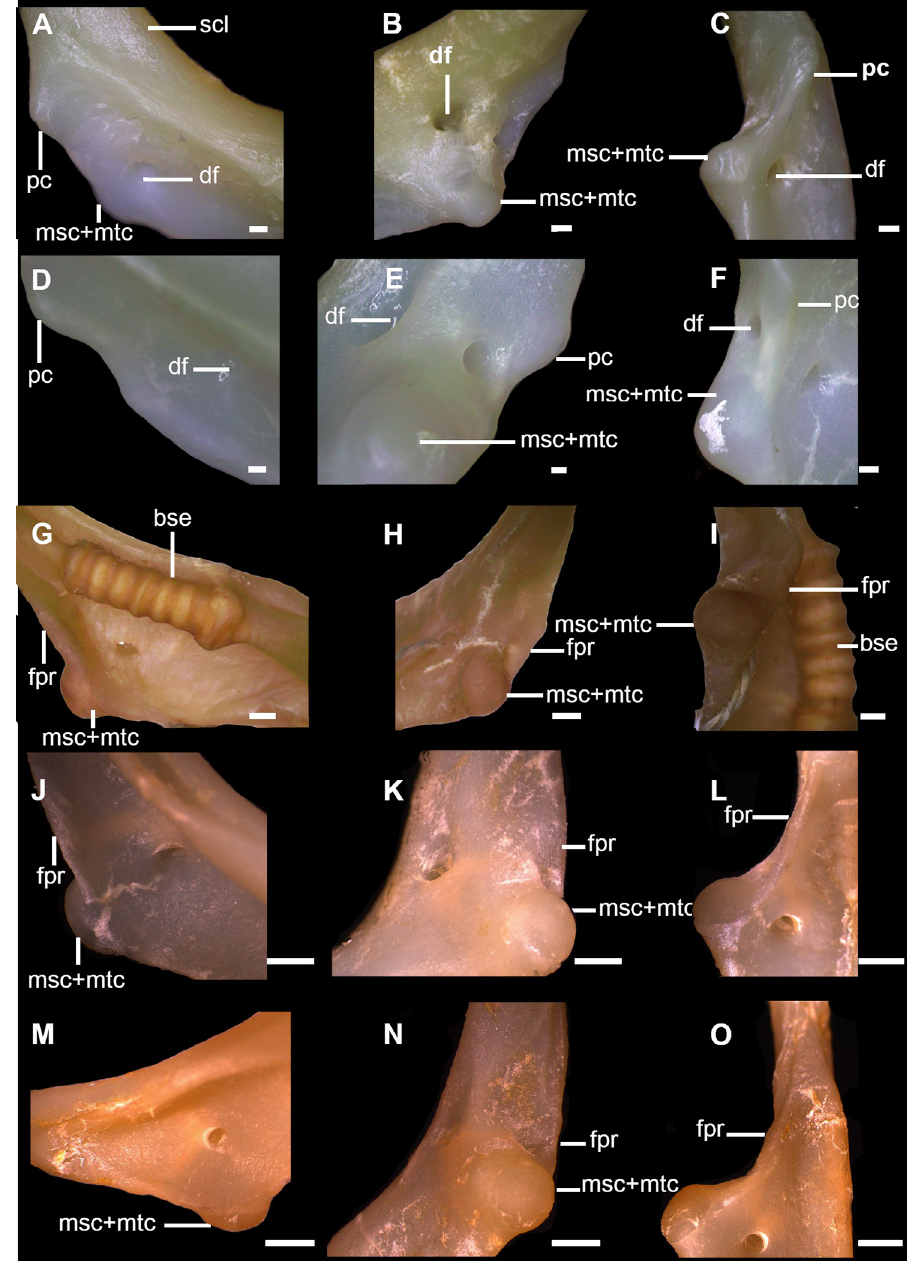
Fig 7. Detail of coracoid bar of Cirrhigaleus and Squalus species in anterior (A,D,G,J,M), posterior (B,E,H,K,N) and lateral views (C,F,I,L,O), showing the pectoral articular region between the pectoral girdle and pectoral basals. A–C: C . australis , CSIRO H7042-04, juvenile female, 605 mm TL; D–F: C . asper , SAM 38269, adult female, 1045 mm TL; G–I: S . acanthias , SAM 38276, adult male, 670mmTL; J–L: S . albifrons , MZUSP 121272, adult male, 760 mm TL; M–O: S . montalbani , MZUSP121270, adult male, 713 mm TL. Abbreviations: bse: barrel-shaped elements; df: diazonal foramen; fpr: facet for propterygium; msc: mesocondyle; mtc: metacondyle; pc: procondyle; scl: scapula. Scale bars: 2